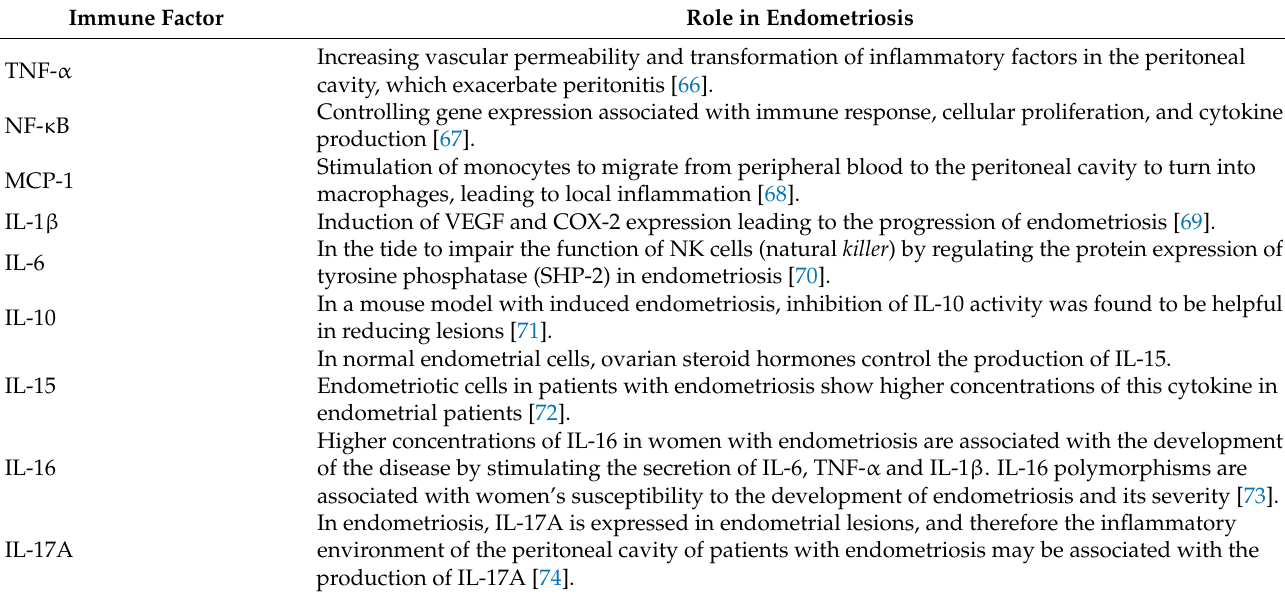
Table 2. Cytokines associated with the development of